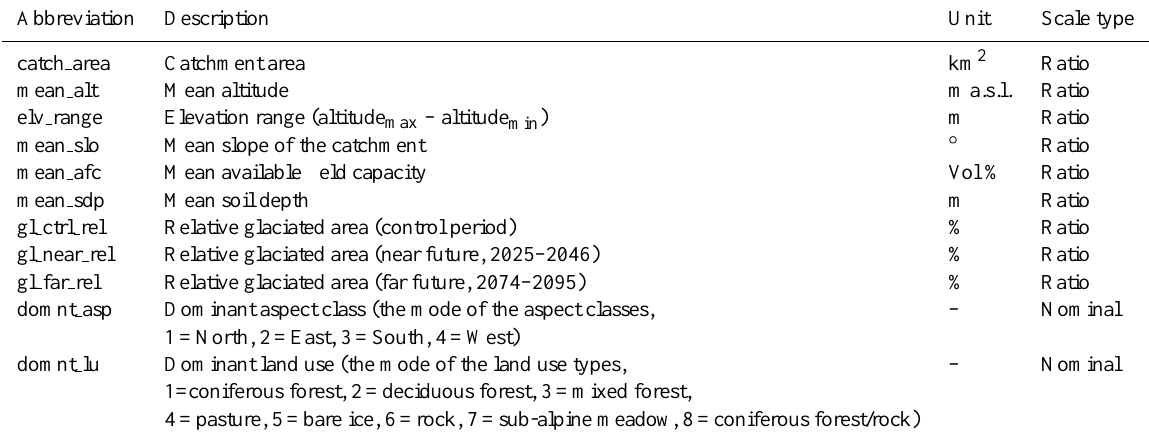
Table 1. Physiographic catchment